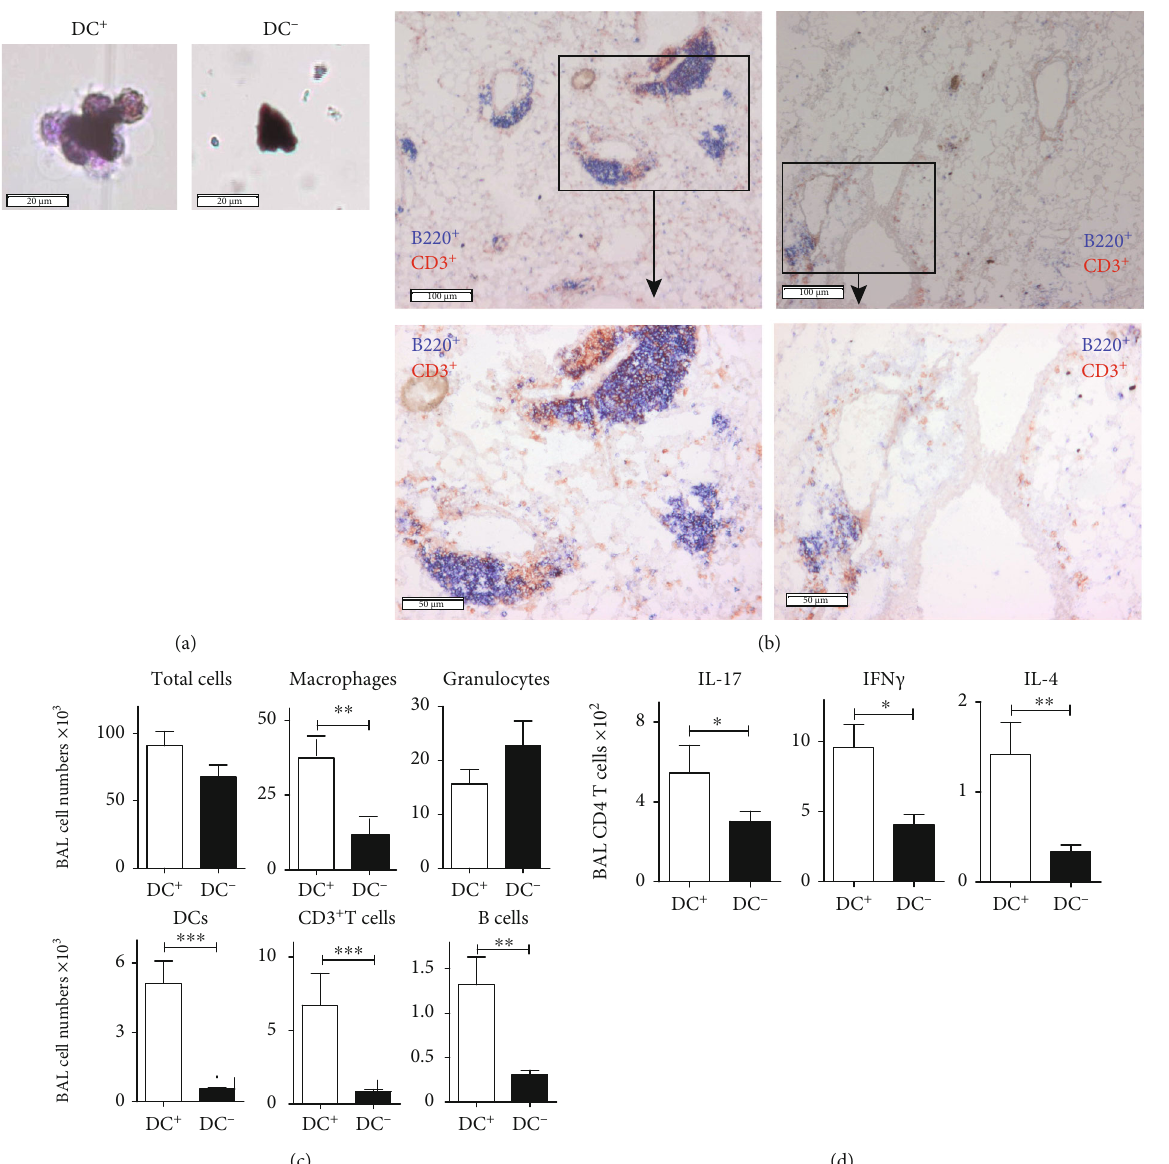
Figure 6: DCs are critical for maintenance of TLSs in the lung of CBD mice. (a) Cytospin analysis of BAL fl uid CBD mice, analysed by hematoxylin and eosin (H&E) staining, showing that nibbling cells around beryllium particles were seen in mice in which DCs were present (DC + ), but not in mice in which DCs were depleted using the CD11c-DTR system (DC - ) 8 weeks after initial exposure (bar, 20 μ m). (b) Lung tissue sections showing the presence of TLSs with perivascular and peribronchial in fi ltrates (DC + , left), but only residual cells are seen as small di ff use in fi ltrates in lung tissue from DC-depleted mice (DC - , right) (bar upper panel 100 μ m; lower panel 50 μ m). (c, d) Quanti fi cation of cellular in fl ammation of the indicated cell types (c) or cytokine production by CD4 + T cells (d) in BAL fl uid from DC + (white bars) and DC-depleted (DC - , black bars) CBD mice. The results shown are expressed as the means ± SEM and represent one out of two independent experiments with 5-6 mice per group. Mann-Whitney U test: ∗ p < 0 : 05 , ∗∗ p < 0 : 01 , and ∗∗∗ p < 0 : 001